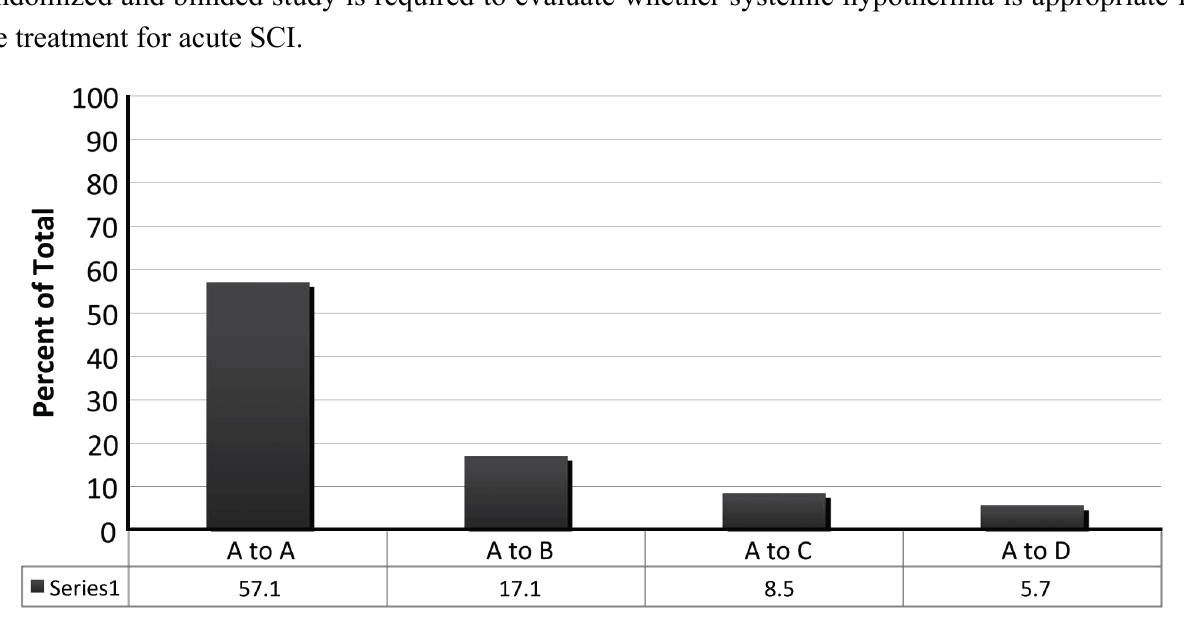
Figure 4. ISNCSCI outcome in 31 patients with initial and stable ISNCSCI A who did not improve within first 24 h from admission. Reprinted with permission from [40], Nature Publishing Group,